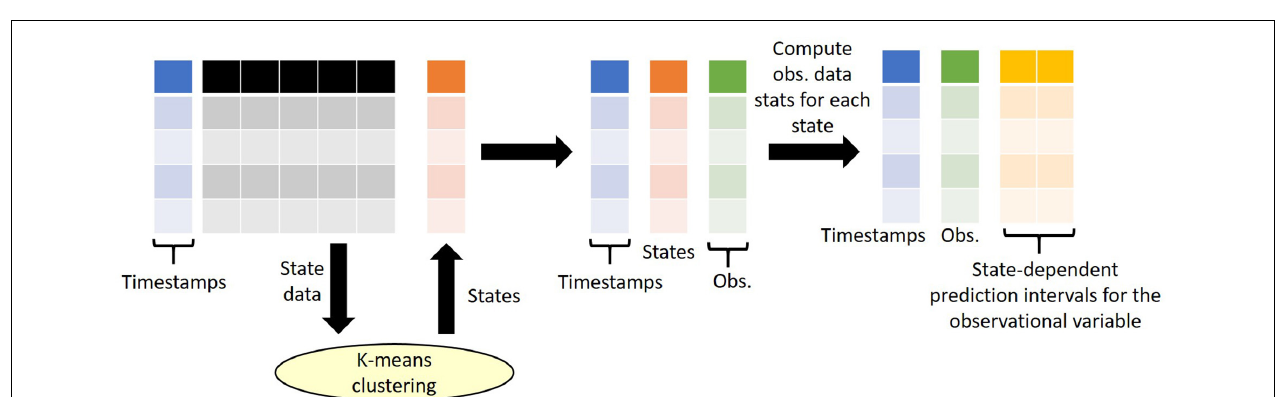
FIGURE 2 | An overview of the state tagging approach. K-means clustering is performed on a selected number of state variables and returns a state number for each row of state data. Note that during the clustering, the timestamps are not considered. Once the states are defined, the states are then attached to the observational data based on matching timestamps (e.g., date). Finally, the statistics of the observational data for each state are computed to derive state-dependent prediction intervals. Observations that fall outside of the prediction intervals are flagged